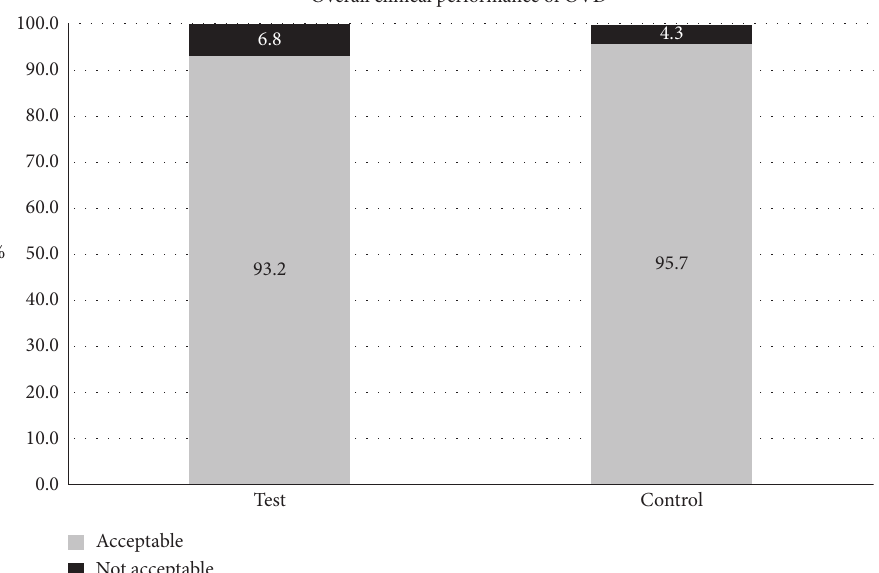
Figure 2: Overall clinical performance of the Healon PRO OVD (test) and Healon OVD (control), “acceptable” having a response of “3, 4, or 5” in the overall clinical performance of the study